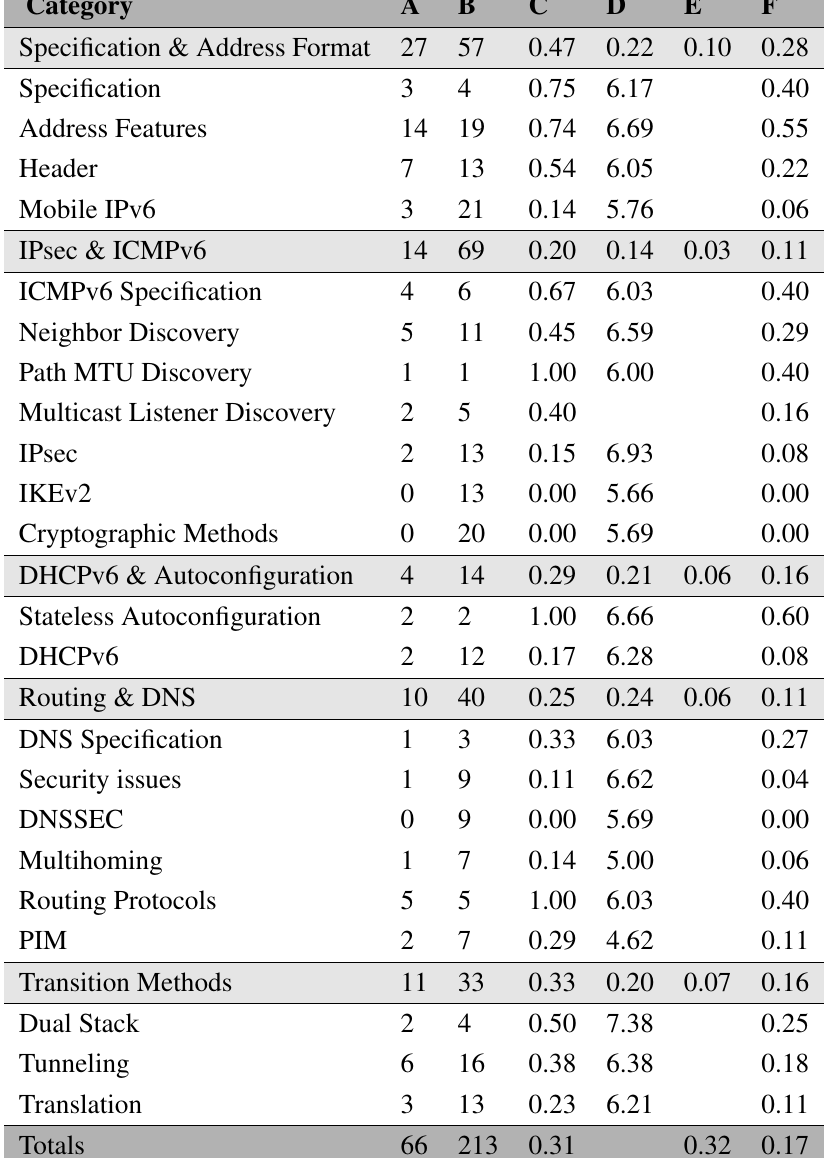
Table 7. BSI Content Completeness and Depth. Columns: A = Count of covered RFCs; B = Count of relevant RFCs; C = Completeness; D = Weight/Importance Rating; E = Weighted Completeness (A * D); F =